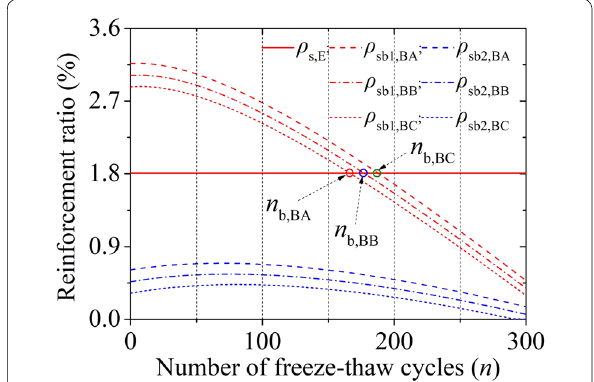
Fig. 13 The corresponding curves of balanced reinforcement ratio and freeze–thaw